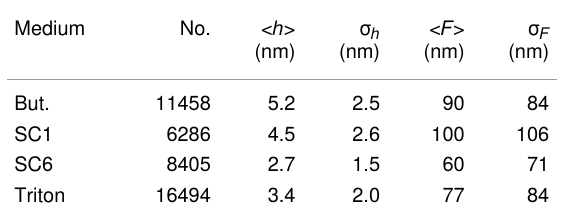
Table 2: Comparison of four different talc LPE samples. The total number of flakes analyzed, mean height ( h ) and its standard